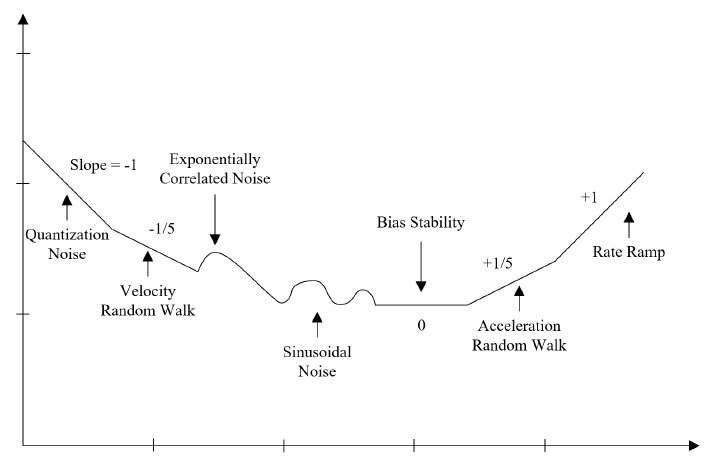
Figure 3. Root Allan variance